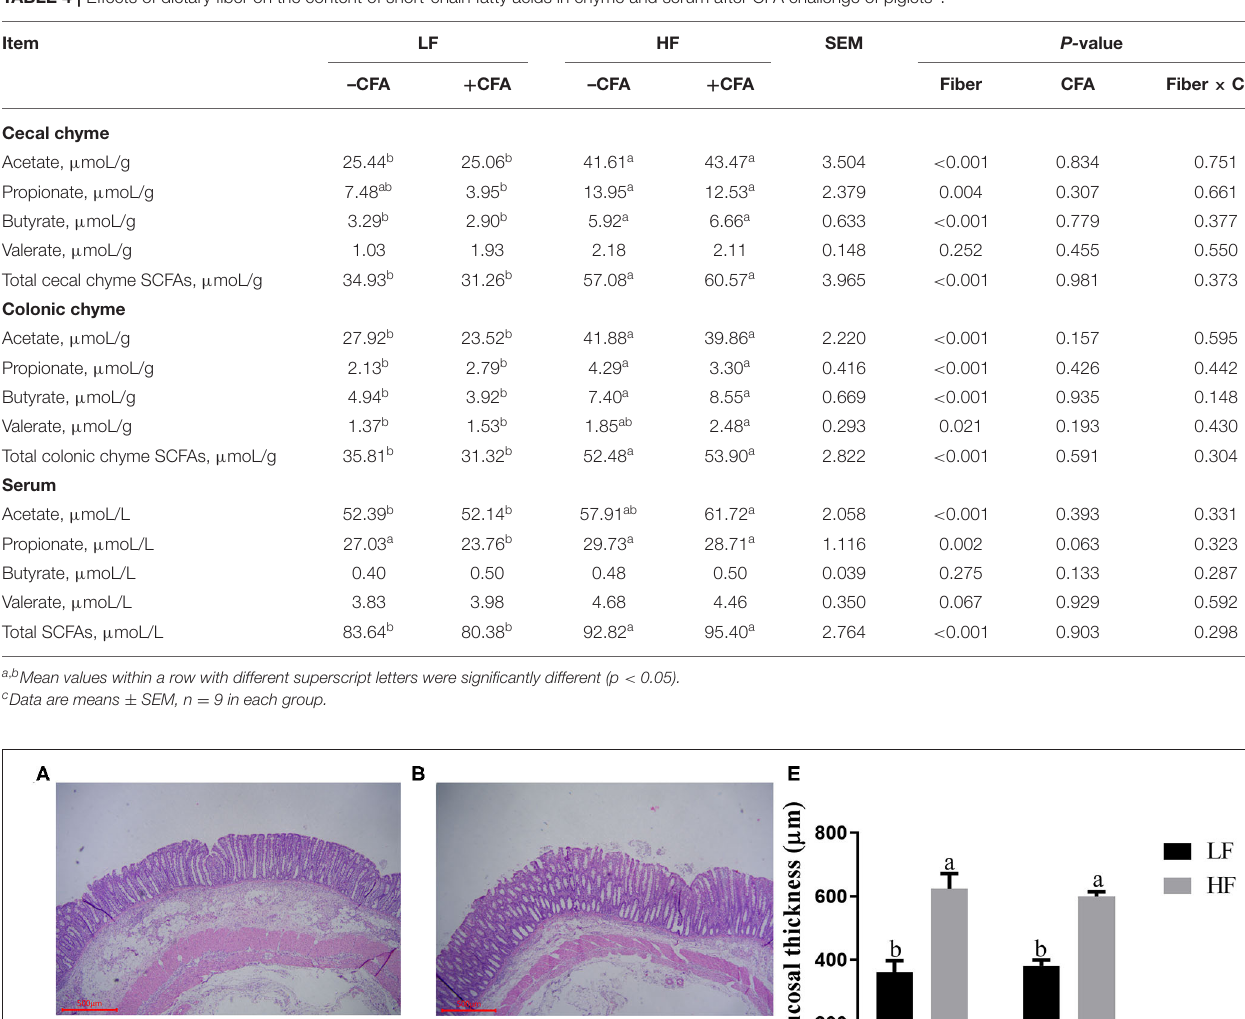
the HF diet treated with CFA ( Figure 9D , p < 0.05) than in piglets fed the LF diet and treated with CFA. The CFA challenge resulted in a greater expression of NLRP3 inflammasome-related genes ( NLRP3 , IL18 , Casp1 , ASC , and IL1 β ) in the lungs ( Figures 10A–E , p < 0.05).